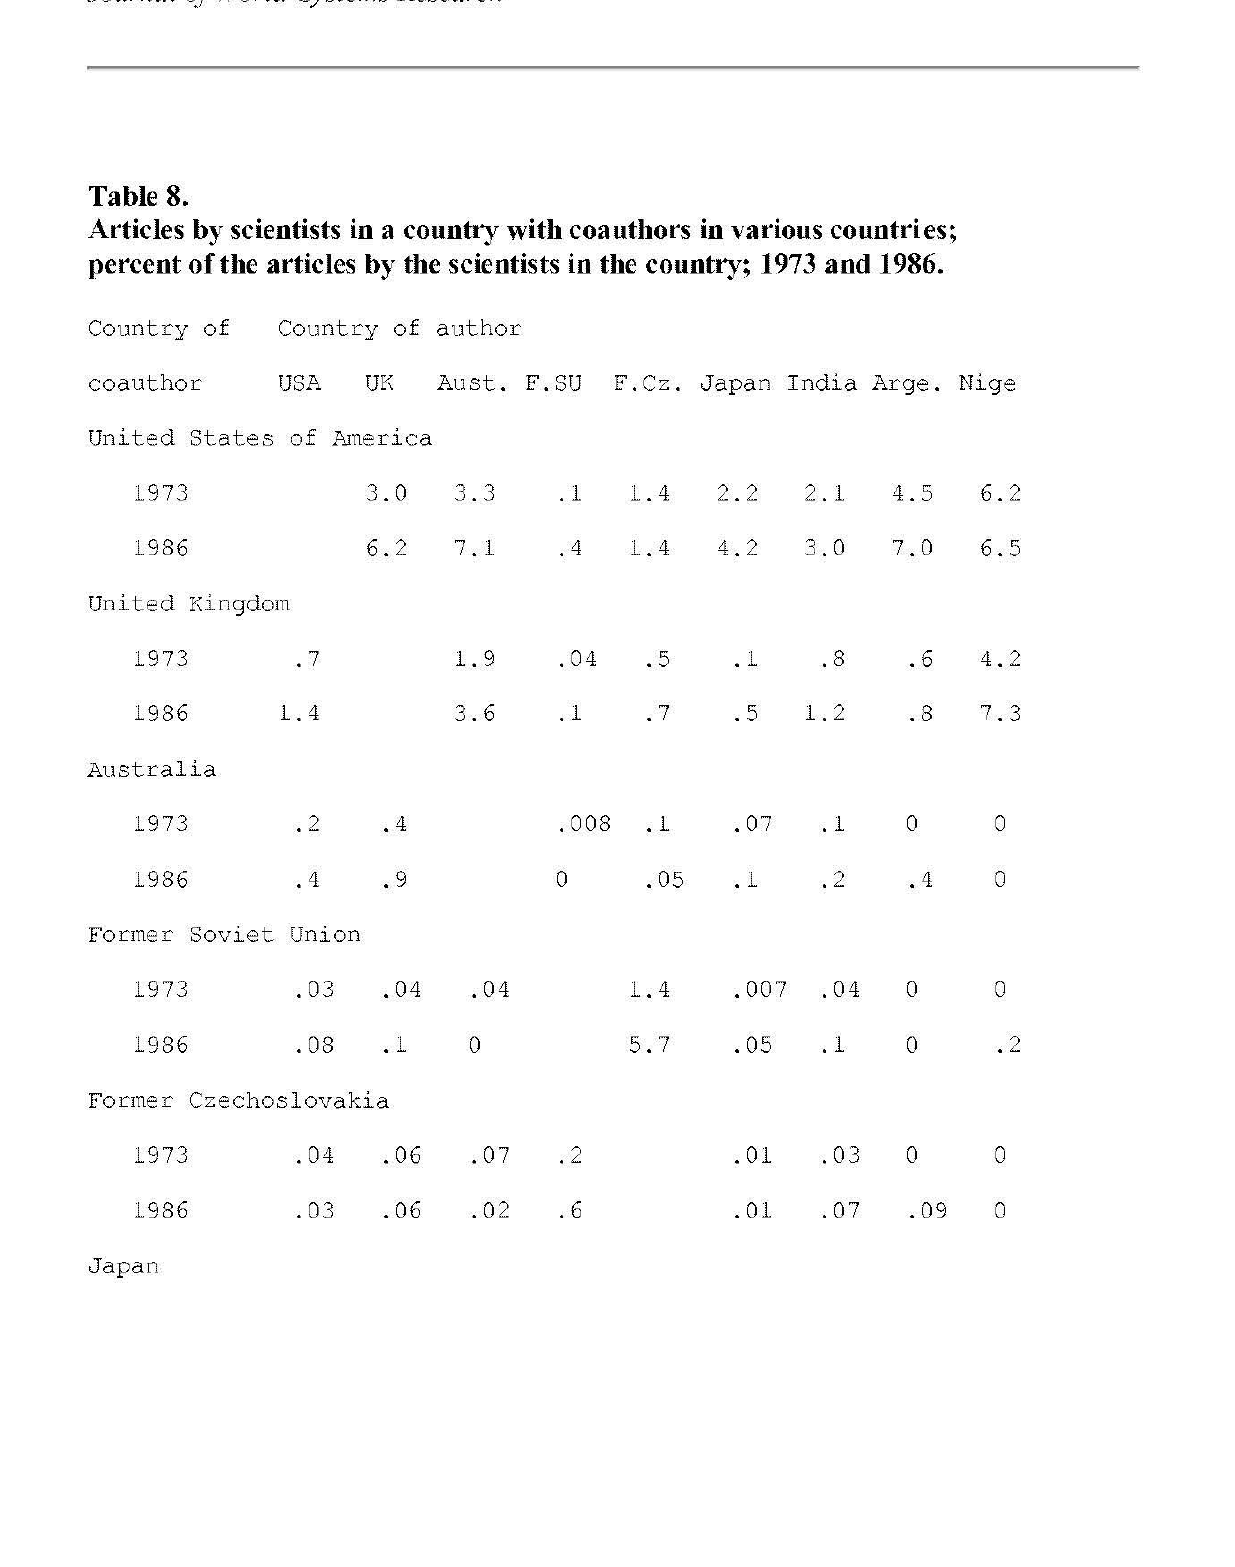
Articles by scientists in a country with coauthors in various countries; percent of the articles by the scientists in the country; 1973 and